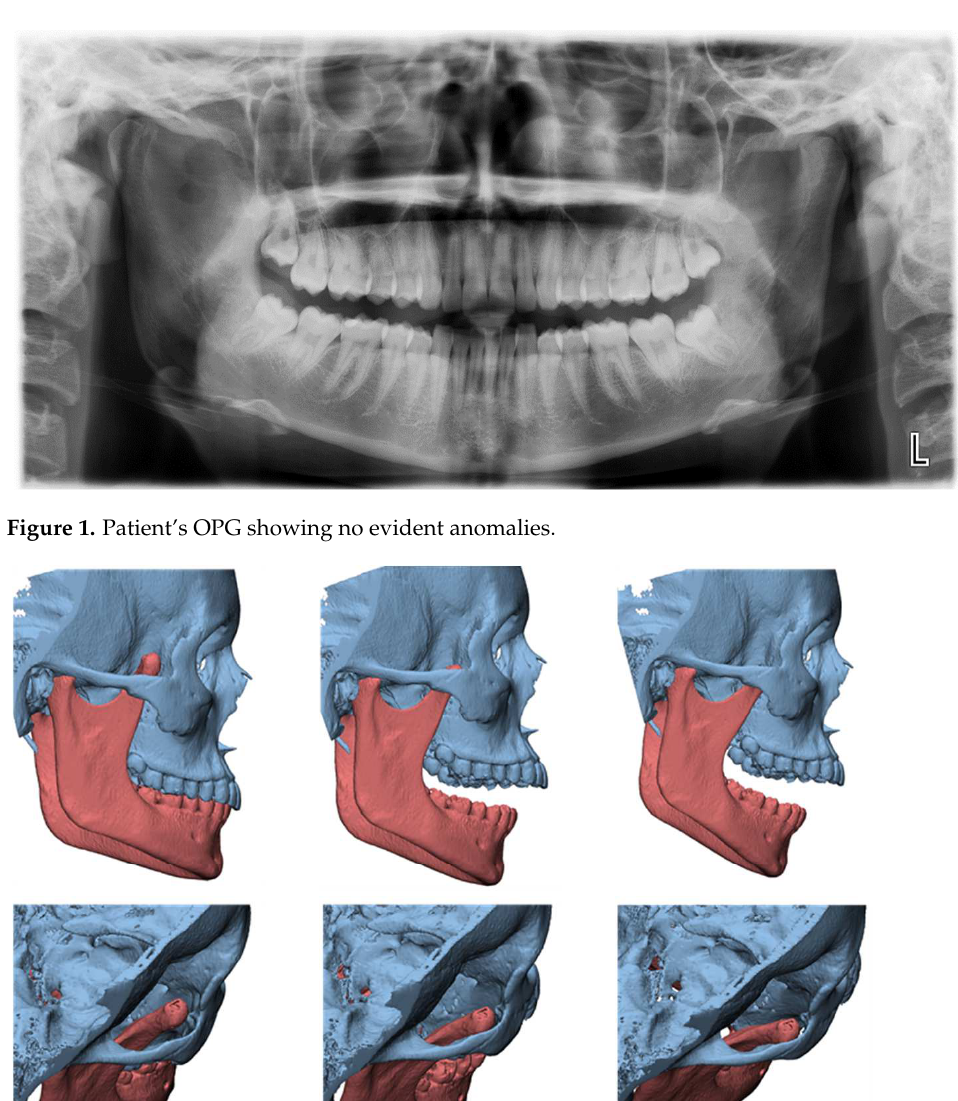
Figure 3. SPET-CT showing bone reworking in correspondence to the joint between the jaw and the right zygomatic bone compared to the contralateral homologous site. Figure 4. Right mushroom-shaped coronoid process excised.